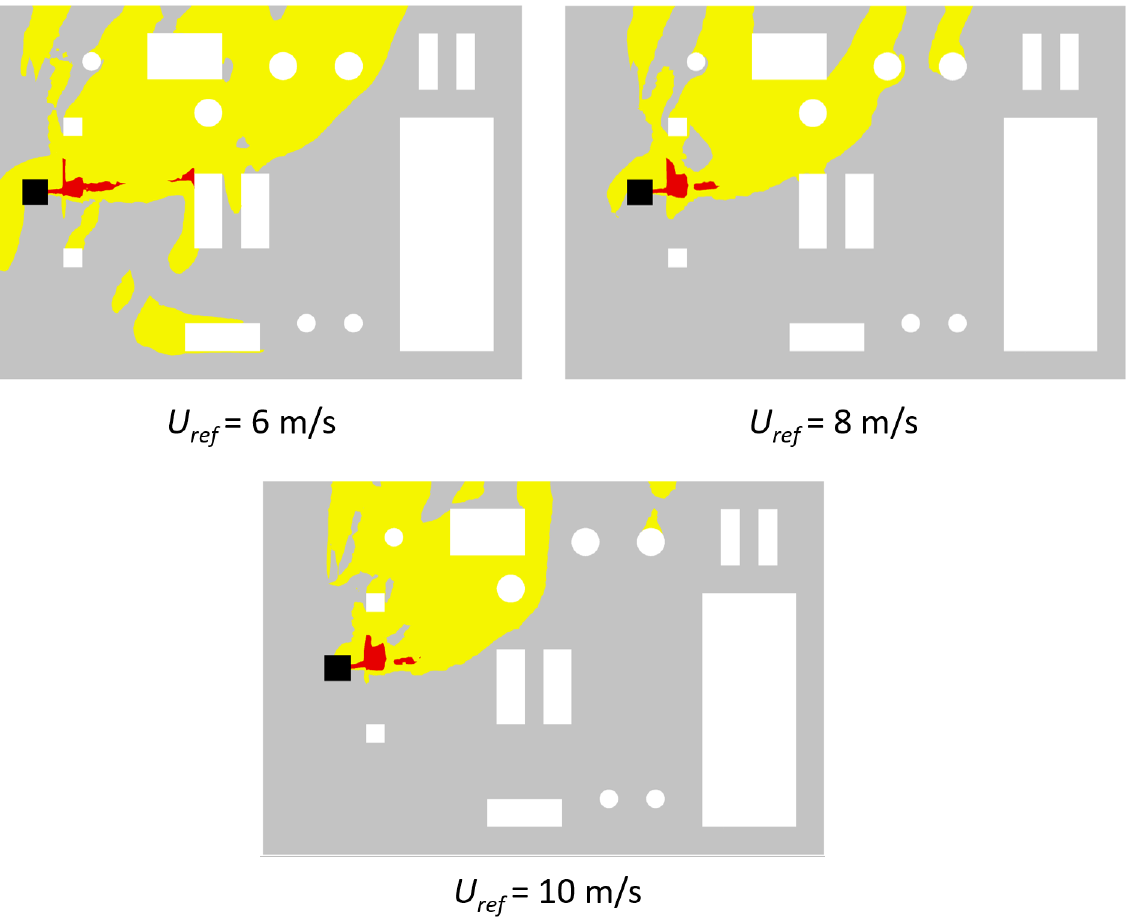
Figure 12. Contour plots on a platform section at height 1.5 m: IDLH area in yellow and LC50 areas in red.